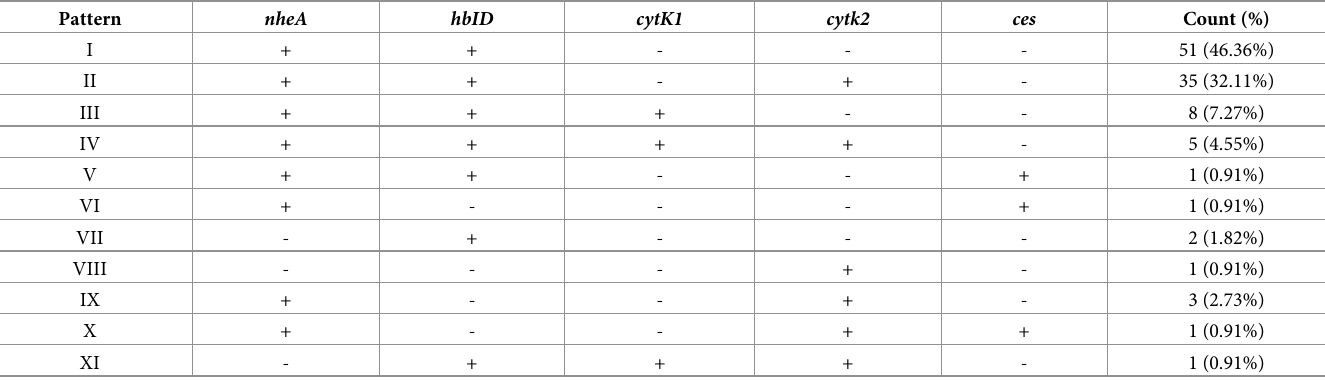
Table 2. Different toxin gene profiles of B . cereus strains used in this study.